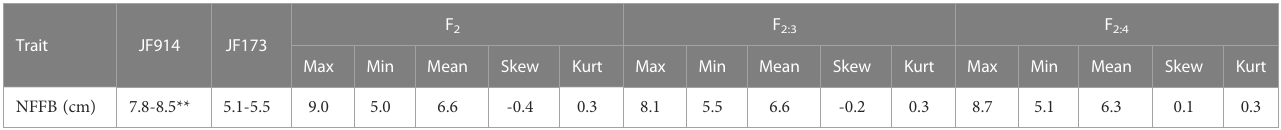
(Table 1). The mean value of NFFB in the segregation populations